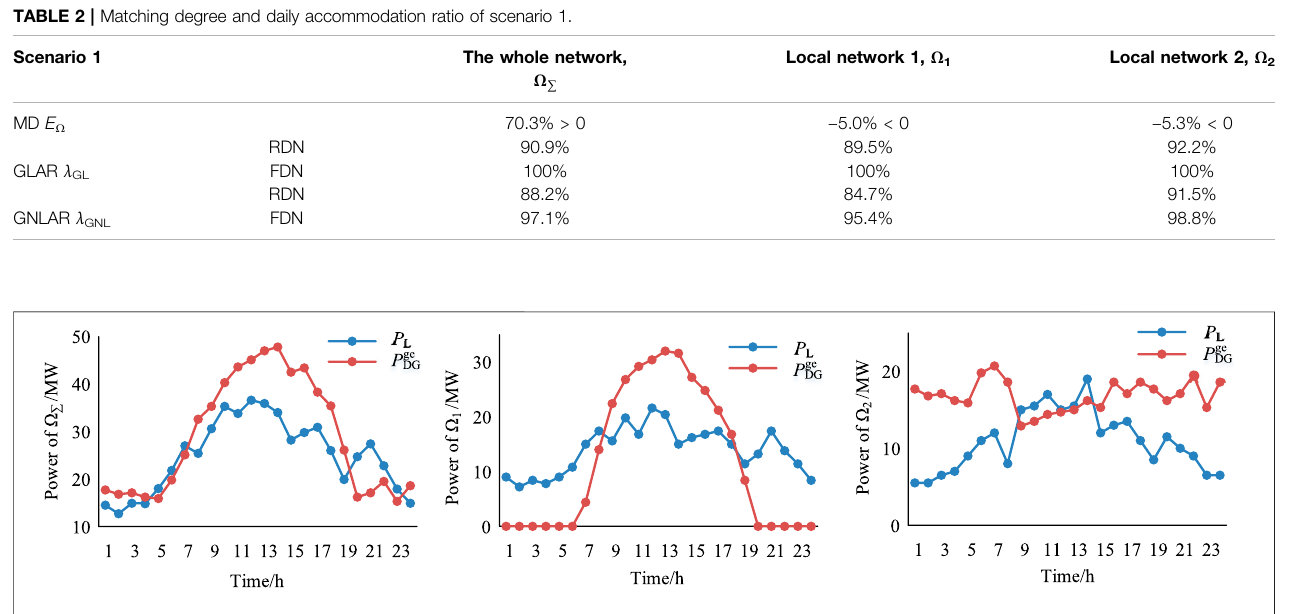
FIGURE 6 | Scenario 2: daily curve of the available output power of DGs and consumption power of the load.